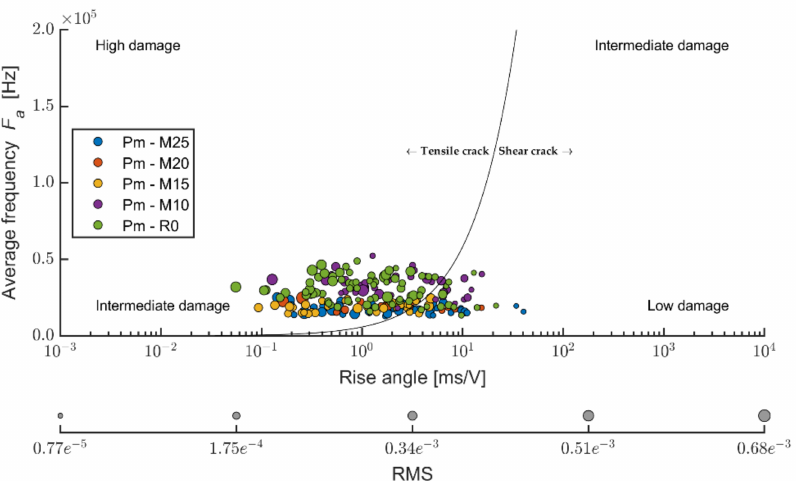
Figure 24. Comparison of average frequency and RA values—relation between tensile and shear cracks in the monitored area of test specimens; mixture PM (boards modified by particle mixture PM) before and after frost/defrost